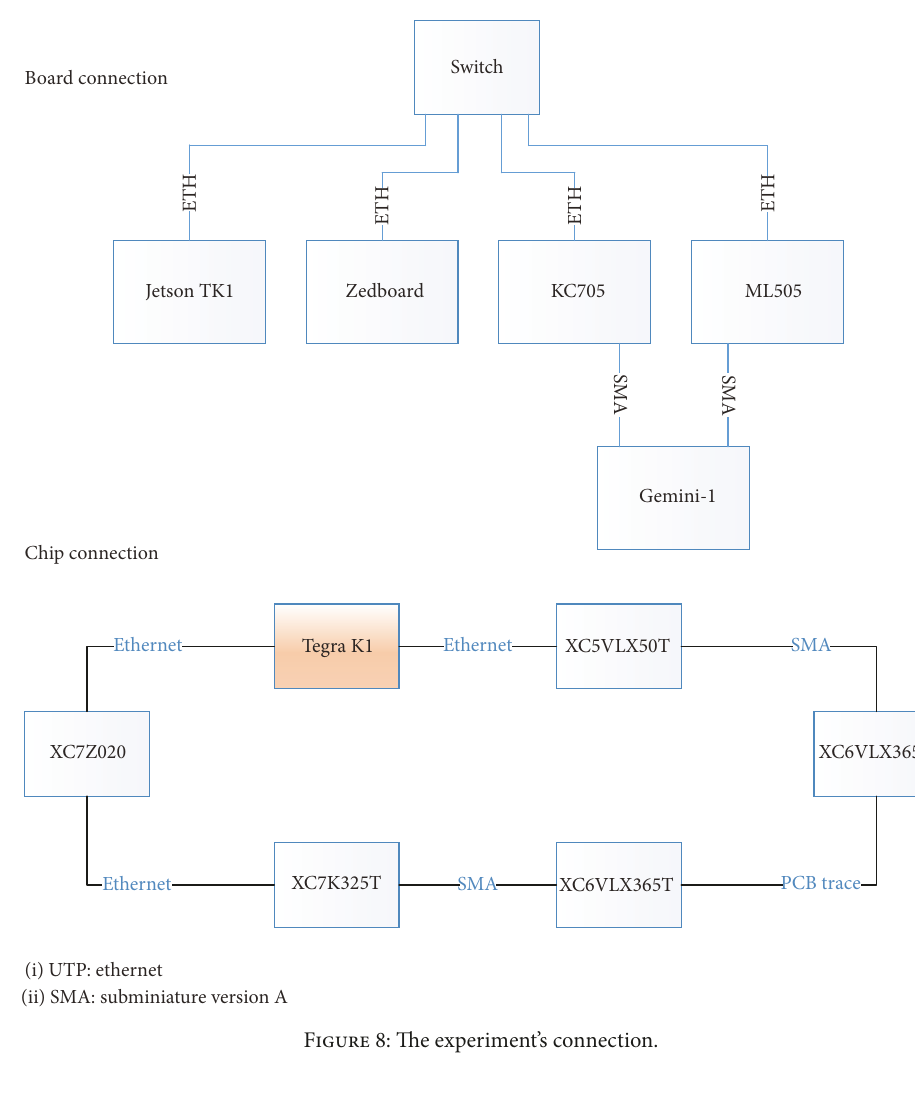
Figure 8: The experiment’s connection.